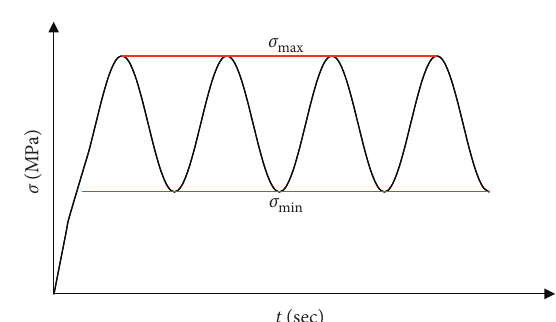
Figure 3: Cyclic loading